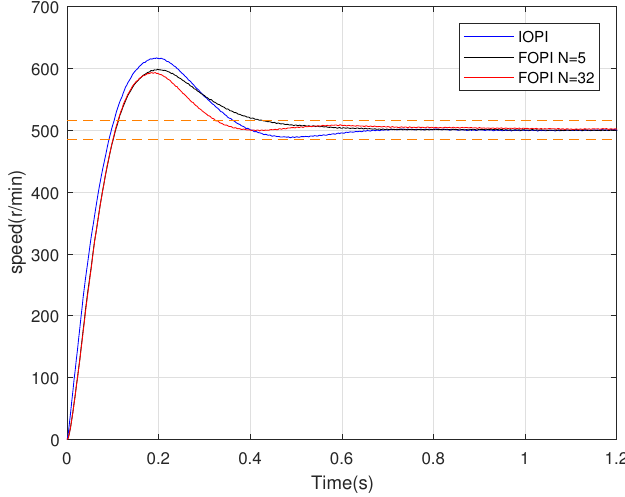
Figure 21. PMSM speed step response